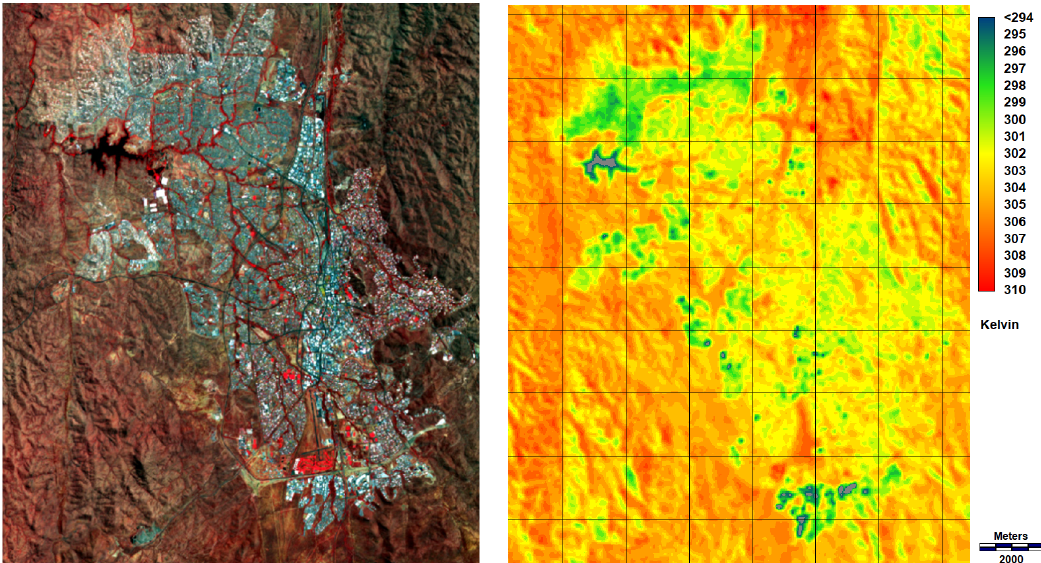
Figure 1. ASTER-RGB image ( left ) and LANDSAT-8-terrestrial emission ( right ), ε = 1.0 of the city of Windhoek,